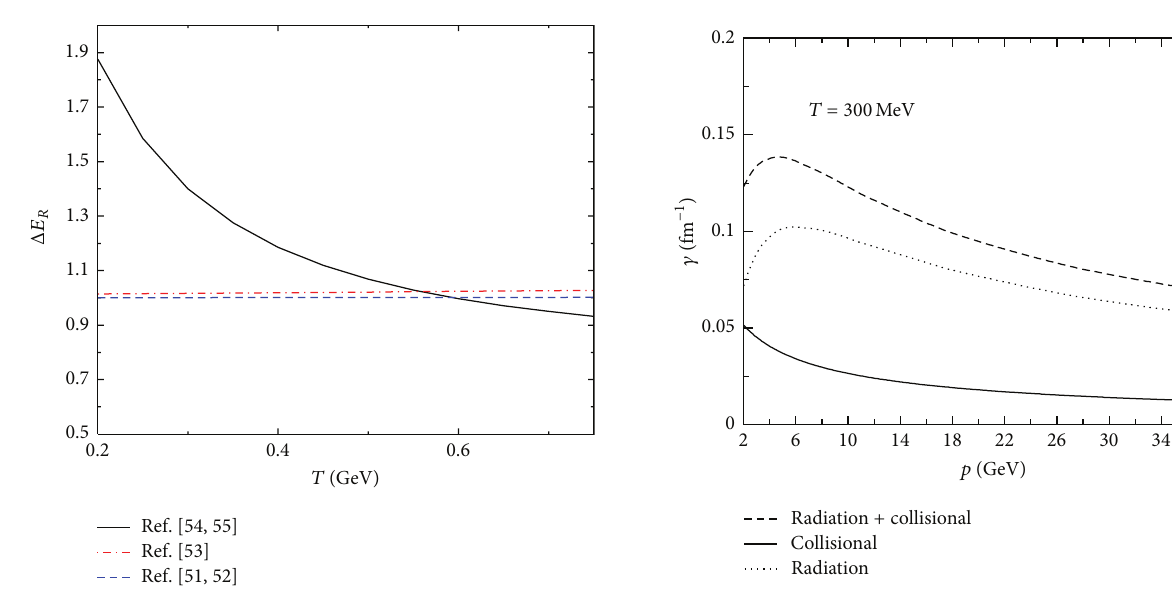
Figure 4: Temperature variation of Δ𝐸 𝑅 , that is, Δ𝐸 normalized by the corresponding value obtained from GB approximation, of a 15GeV gluon due to traversal of 4 fm in a gluonic heat bath. Solid (dashed) line indicates result for the gluon spectrum obtained (Color online) in [61, 63]. The dot-dashed line stands for the results for the gluon spectrum of [62].